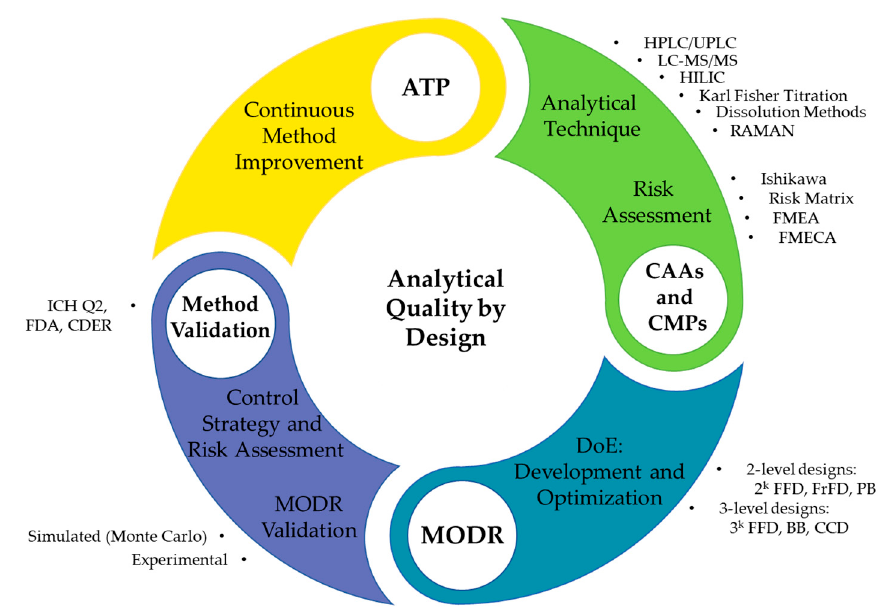
Figure 2. Analytical Quality by Design (AQbD) Workflow.